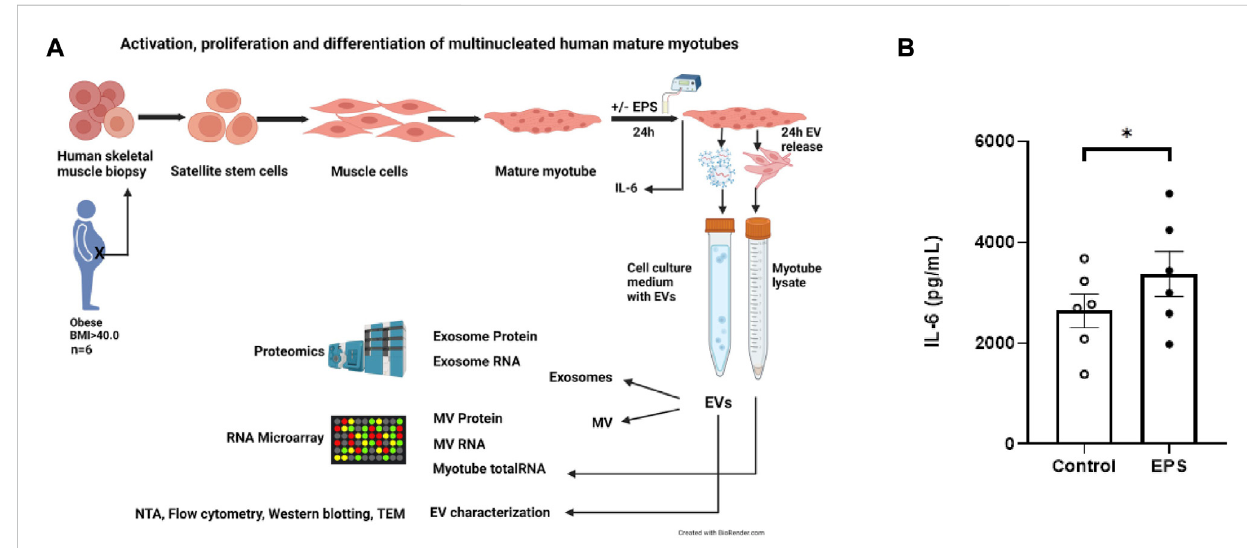
FIGURE 1 Study work fl ow and cell medium concentration of interleukin-6 (IL-6). Flow chart of the study from human biopsy sampling, skeletal muscle cell culturing, electrical pulse stimulation (EPS) of myotubes, isolation of extracellular vesicles (EVs) from conditioned medium, separation of exosomes from microvesicles (MV), characterization of EVs by nanoparticle tracking analysis (NTA), fl ow cytometry, Western blotting, transmission electron microscopy (TEM) to transcriptomic (RNA microarray) and proteomic analysis (A) . Cultured human myotubes were exposed to EPS for 24 h, conditioned mediumwasharvested,andtheconcentrationofIL-6wasdetectedwithahumanELISAkitaccordingtotheproducer ’ sprotocol(SigmaAldrich).Dataare given as mean (±SEM) ( n = 6). *Signi fi cantly different from control (unstimulated cells) p < 0.05 (B)